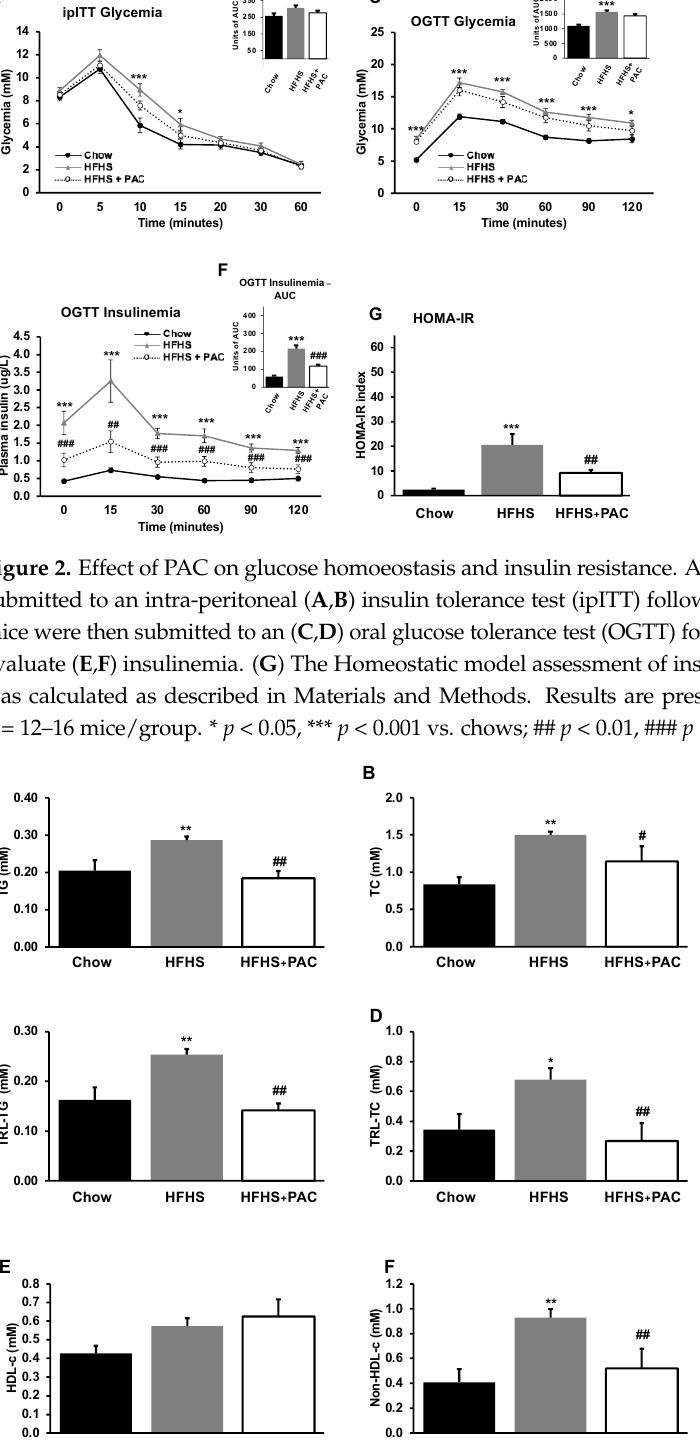
Figure 4A, HFHS-diet contributed to raise the plasma LPS levels, a trigger of intestinal permeability and endotoxemia. While HFHS caused an accretion of LPS, PACs alleviated diet-induced LPS levels. We subsequently evaluated the status of F2-isoprostane and MDA (Figure 4B,C), two lipid peroxidation markers. Treatment with PACs normalized MDA and F2-isoprostane concentrations.